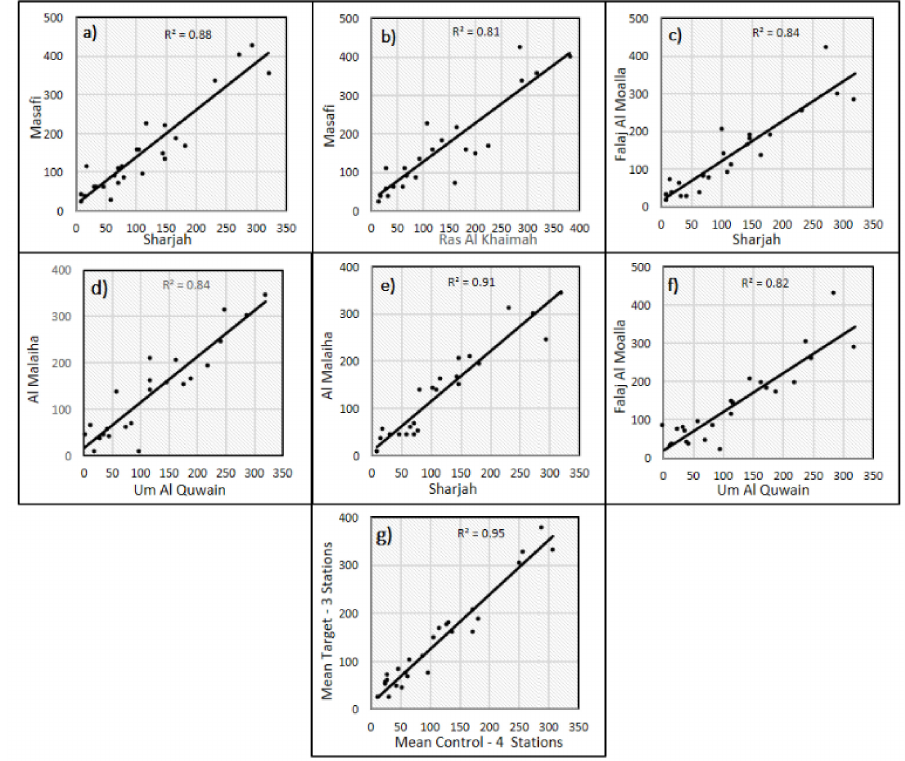
Figure 3. ( a – g ) Scatterplots of observed annual rainfall (mm/year) for control vs. target gauges during 1980–2002, with fitted regression lines and R 2 values denoted in each